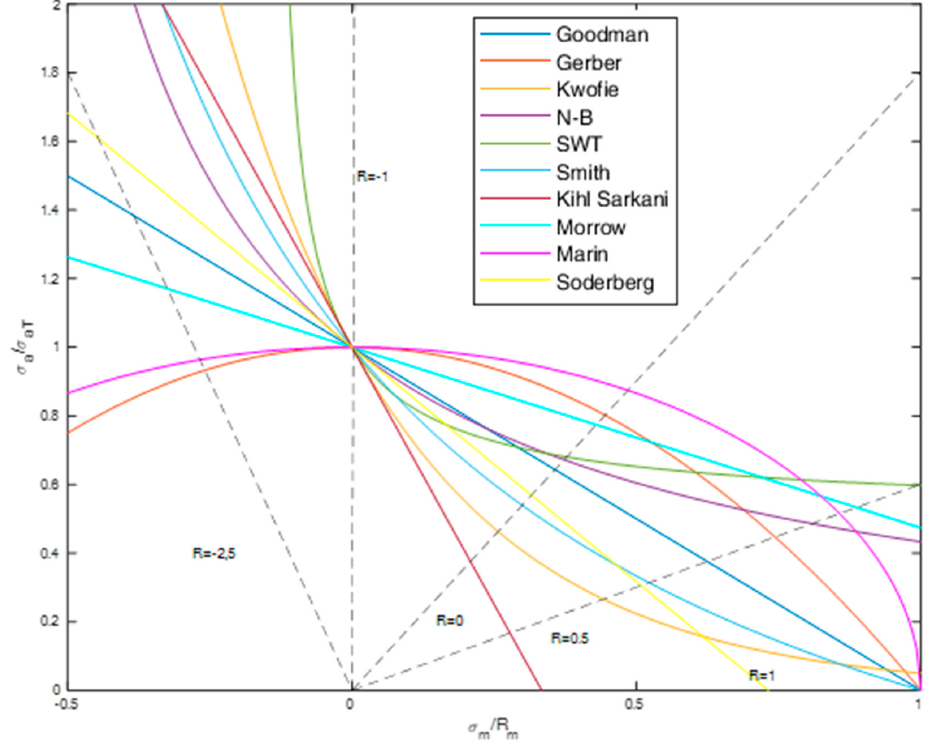
Figure 2. Some of the most popular mean stress compensation models.